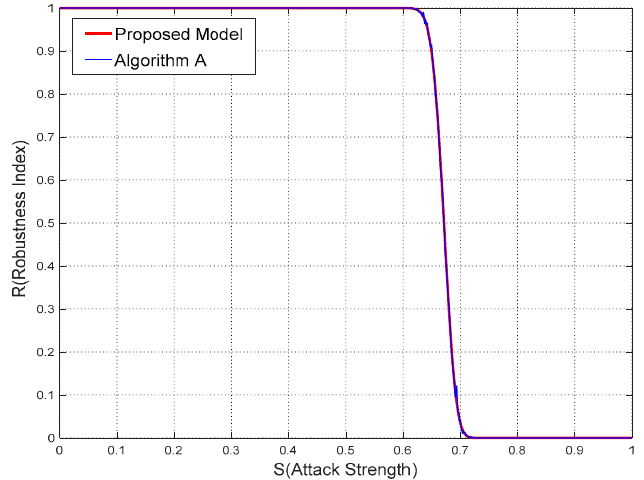
Figure 11. Comparisons of results from proposed model and Algorithm A in Experiment 1.